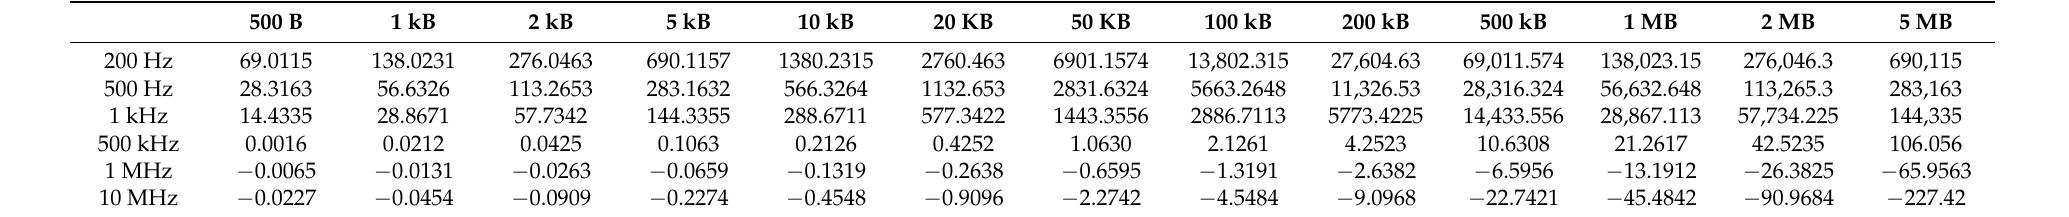
Table 4. Threshold difference values between offloading and local for the relay node ( T of f − T loc